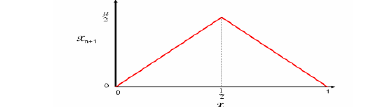
Figure 3. Chaotic behavior of the Tent